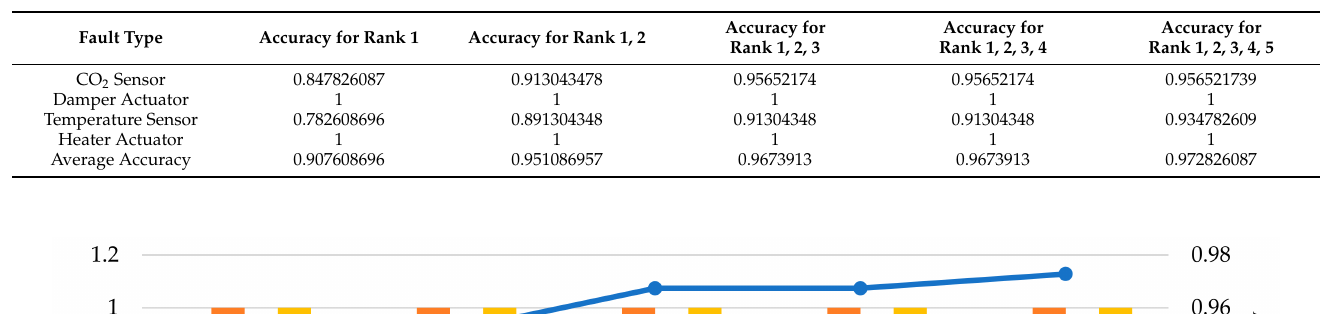
Table 25. Accuracy of diagnostic classifier in different cumulative ranks for different fault types.